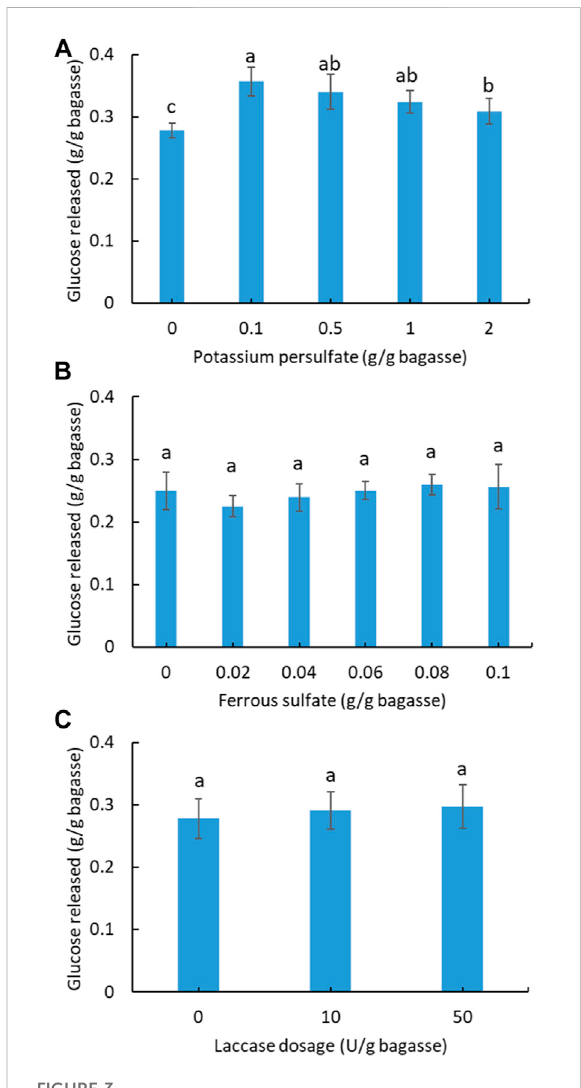
FIGURE 3 Effect of potassium persulfate (A) and activated persulfate with ferrous sulfate pretreatment (B) of SCB on the subsequent hydrolysis. (C) Effect of laccase addition on the hydrolysis of SCB. (Reaction condition: 0.1 g of pretreated SCB, cellulase ~38.5 U/g bagasse, 400 μ g tetracycline and 300 μ g cycloheximide, pH 4.8, temperature 50 ° C, and time 24 h. Final volume: 10 ml in each vial.) (Glucose content within all columns with a letter in common are not signi fi cantly different at p < 0.05 level, n =